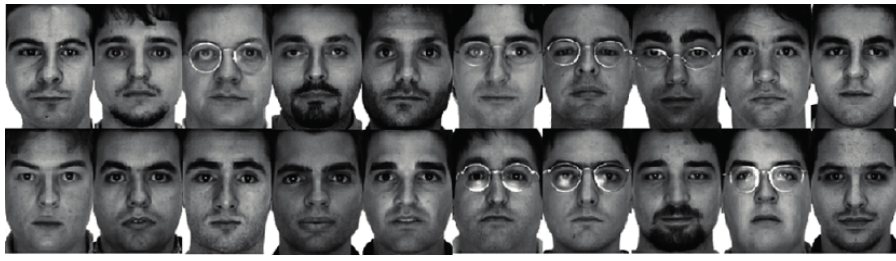
Figure 5. Some specific selected subjects from AR Face Dataset in our experiment.